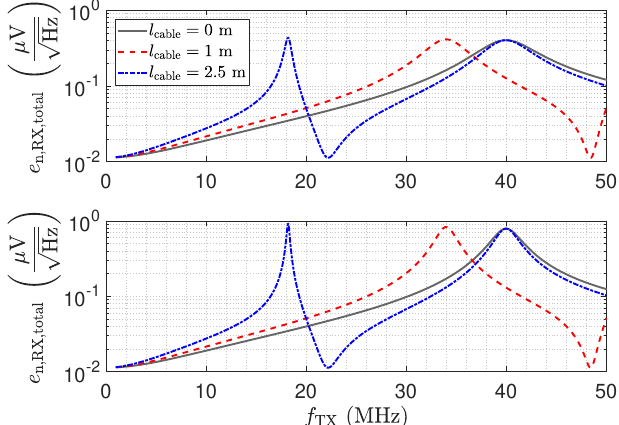
Figure 29. Upper plot: Total output voltage noise spectral density of the investigated matched resonant LCR input stage with Q matched = 7.36, for three different transmission line lengths. Lower plot: Total output voltage noise spectral density of a non-matched resonant LCR input stage with Q = 16.36, for three different transmission line lengths. The SPICE-based simulation includes the capacitive Π